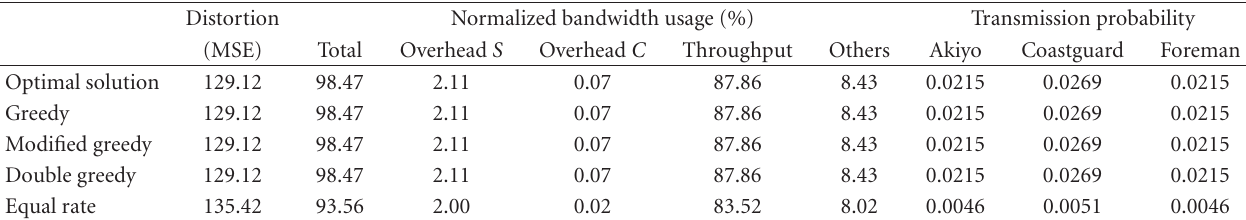
Table 5: Detail information associated with di ff erent algorithms for video profiles I (BW = 1 . 2 Mb/s).